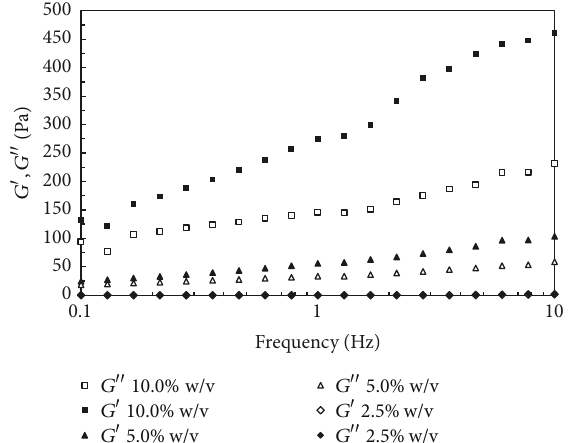
Figure 6: Elastic moduli, 𝐺 󸀠 , and viscous moduli, 𝐺 󸀠󸀠 , as a function of frequency at 37 ∘ C of the purified dextran from W. confusa R003 at the concentration of 2.5, 5.0, and 10.0% w/v.